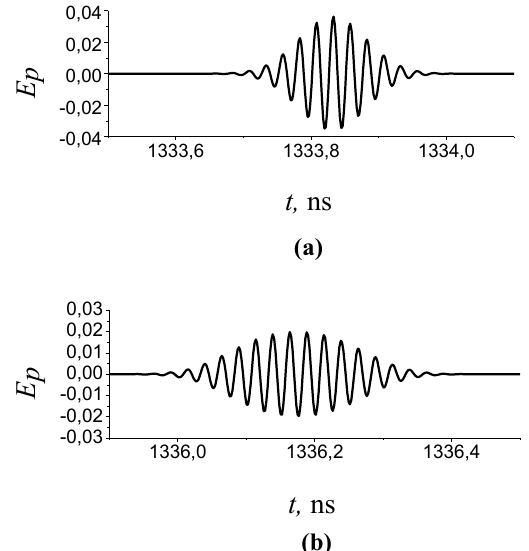
Fig. 5. Pulses in two points of far field cross section z=L . a - in the main maximum 0  X and b - in the first side maximum 0  X .